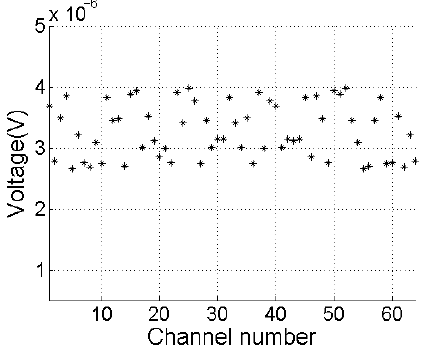
Figure 23. Background noise of channel #56.